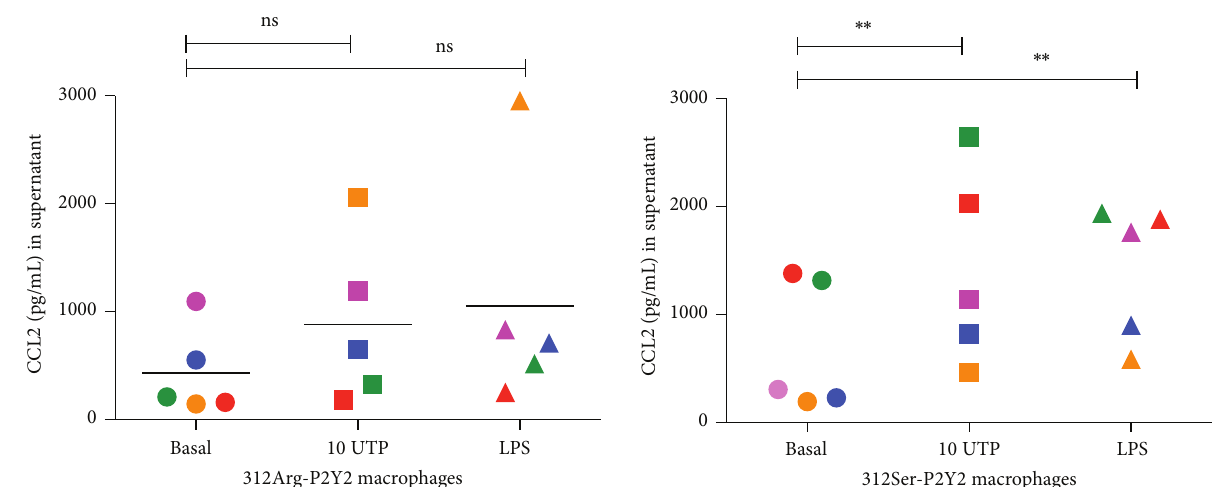
Figure 9: Macrophages expressing 312Ser-P2Y2 secrete higher levels of CCL2 in response to UTP and LPS. Human adherent PBMCs were plated at 2.5 × 10 6 cells/well and cultured for 7 days. Media were replaced and cells were stimulated with media, 10 𝜇 M UTP, or 100 𝜇 g/mL LPS for 4 hours. Each symbol represents a different donor ( 𝑛 = 5 donors per genotype group) and each donor has a different colour. Bars represent the mean data for each condition. ∗∗ denotes 𝑃 < 0.05 using a one-way ANOVA with Dunnett’s post hoc test; ns denotes not